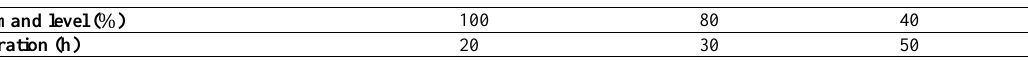
Table 12. Parameters of the cumulative load demand curve (Example 2).